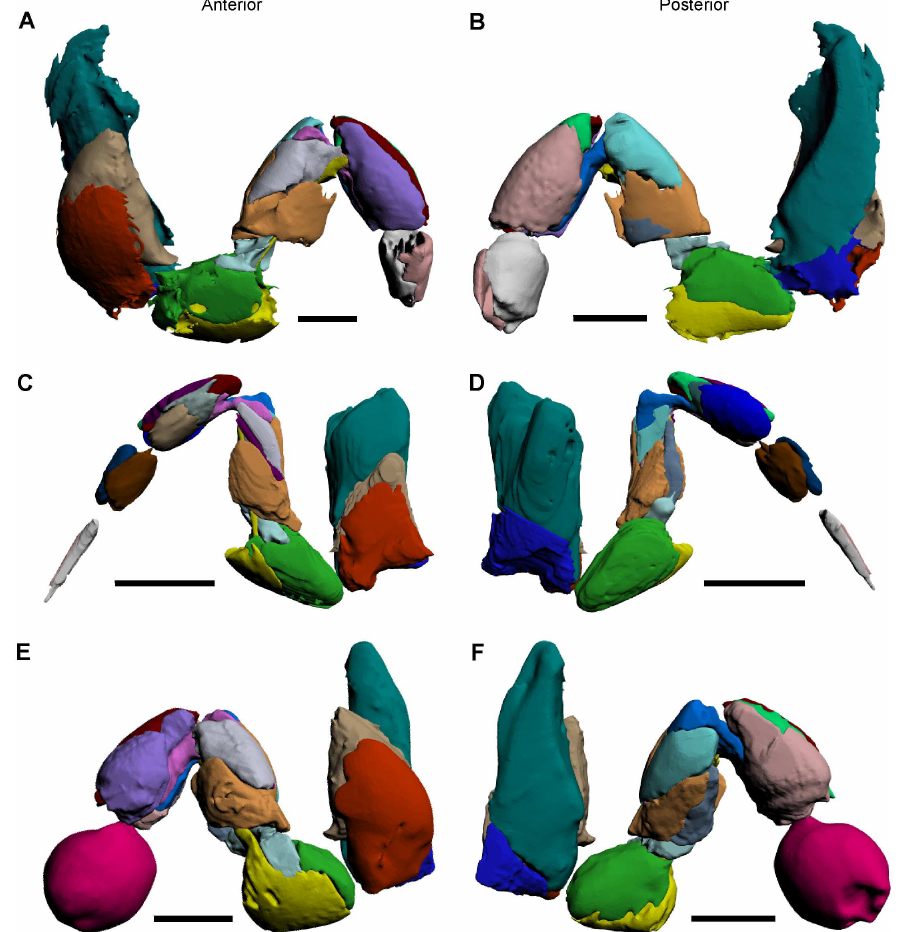
Fig 4. 3D reconstructions of identified muscles within the walking leg (A, B), pushing leg (C, D), and male pedipalp (E, F), as modelled from iodine staining and micro-CT–scanning. A key is not included, as deeper muscles cannot easily be visualized in this figure. Individual muscles of specific prosomal appendages are illustrated separately in Figs 5–8. Reconstructions in the left column (A, C, E) are all anterior views and reconstructions in the right column (B, D, F) are all posterior views. These reconstructions should be considered in conjunction with the cephalothoracic appendage reconstructions in Fig 3. The 3D versions of these files are available in the Supporting Information (S3, S4 and S5 Figs). Scale bars 10 mm for A, B, E, F; 20 mm for C,